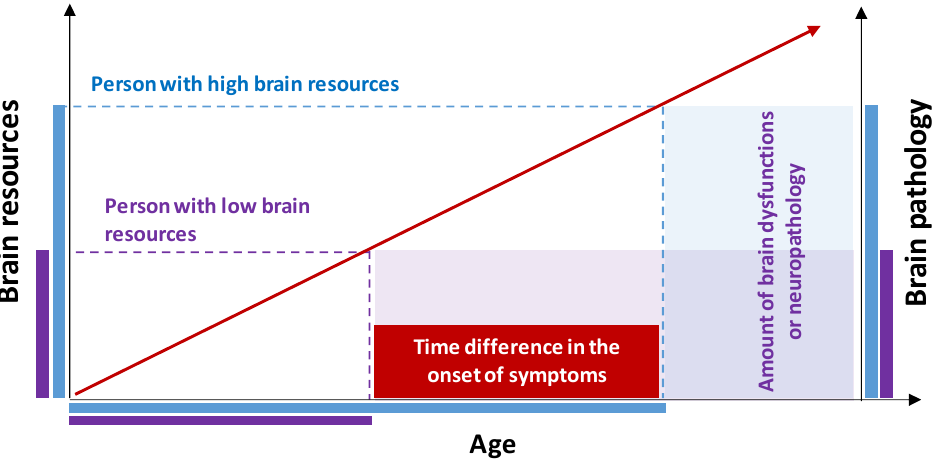
Figure 4. Diagrammatic representation of the interrelation between brain resources, age, and amount of brain dysfunctions or neuropathology. Red arrow = brain dysfunctions or neuropathology. Individuals with high brain resources are able to compensate for dysfunctions or structural damage for a longer period of time, and thus, symptoms do not manifest at low/moderate degrees of neural dysfunction/damage. However, after reaching a critical threshold at which the compensatory mechanisms are exhausted, clinical impairment progresses quickly. In contrast, slight brain damage or dysfunction is sufficient to produce clinical symptoms in individuals with low brain resources due to a weaker deployment of functional compensatory mechanisms. Consequently, they exhibit clinical symptoms at an earlier age and stage of the disease; however, these clinical symp- toms progress slowly as pathologic neural changes slowly accrue. The period of time that elapses between the onset of clinical symptoms and the advanced stages of cognitive impairment is shorter in individuals with high brain resources compared to individuals with low brain resources because individuals with high brain resources remain asymptomatic during the early stages, before com- pensatory mechanisms are exhausted, but individuals with low brain resources already show clini- cal symptoms during those stages (description is modified from [674]). A person with low overall brain resources has decreased compensatory and neuro- protective mechanisms that decrease the capacity for effective cognitive functioning even without neuropathophysiological challenges. A person with fewer brain resources has an older brain phenotype, so he or she may express symptoms after a trivial brain dysfunc- tion due to redundant neural pathways and an inflexible or intolerant functional network. Likewise, the brain has a lower threshold for the expression of functional impairments following the onset of brain pathology [667,672,673] (Figure 4).